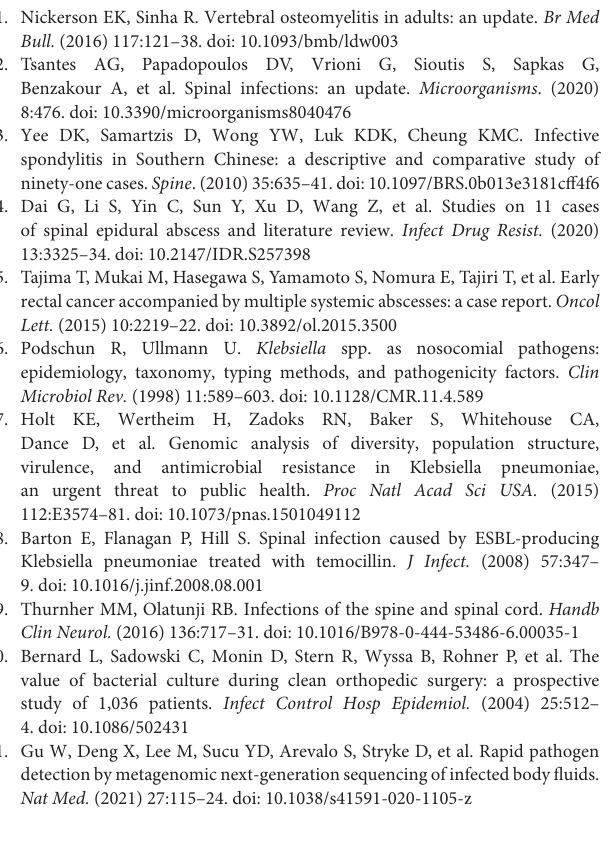
Supplementary Figure 1 | Pathological results of the patient. (A,B) The pathological section of the C5/6 intervertebral disc showed a large number of inflammatory cells exudate, suggesting chronic suppurative